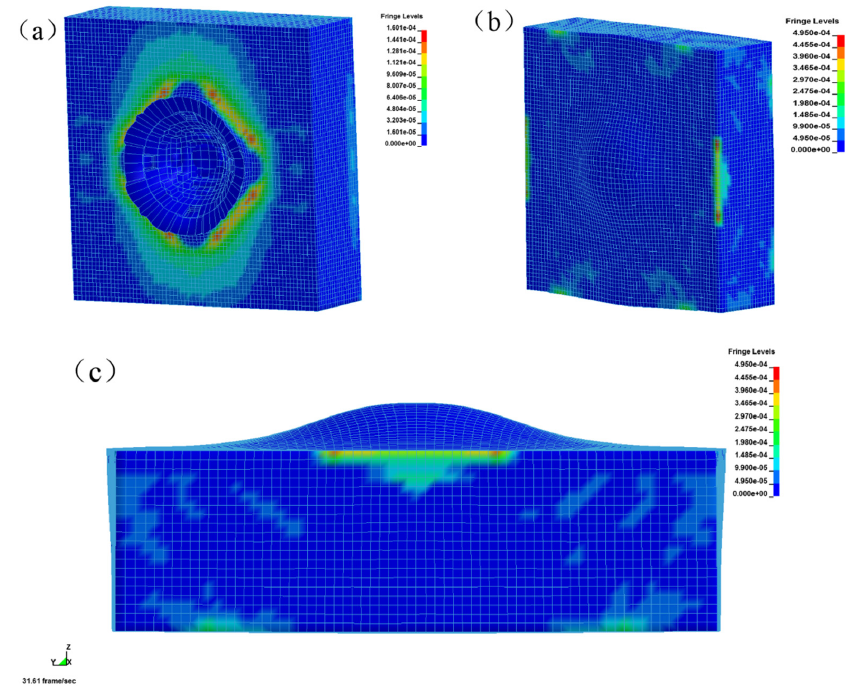
Figure 16. Stress nephograms of uncoated reinforced concrete slab at time t = 1000 μ s: ( a ) face surface blast; ( b ) back blast surface; ( c ) side face.